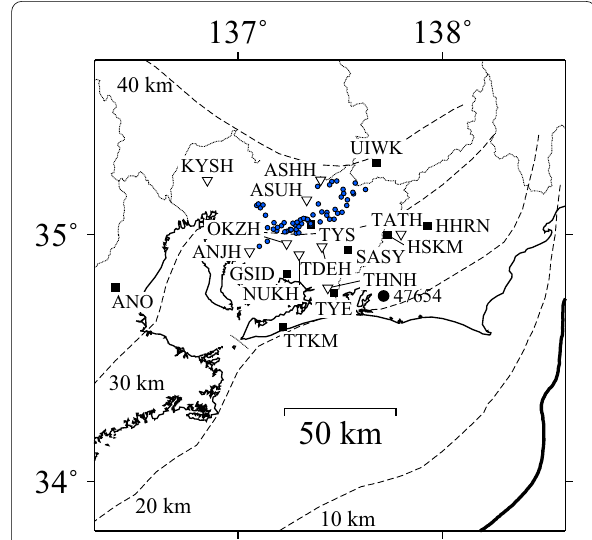
Fig. 5 Epicentral distribution of LFTs (dots) observed in the Tokai region during 14–19 April 2015 (NIED catalog). Also shown are locations of strain observation stations (squares), Hi-net (tilt data) stations (triangles), and Hamamatsu weather station 47654 (circle). Map region corresponds to Area B in Fig. 1. The solid line indicates the Nankai Trough and dashed contours indicate the depth of the Philippine Sea